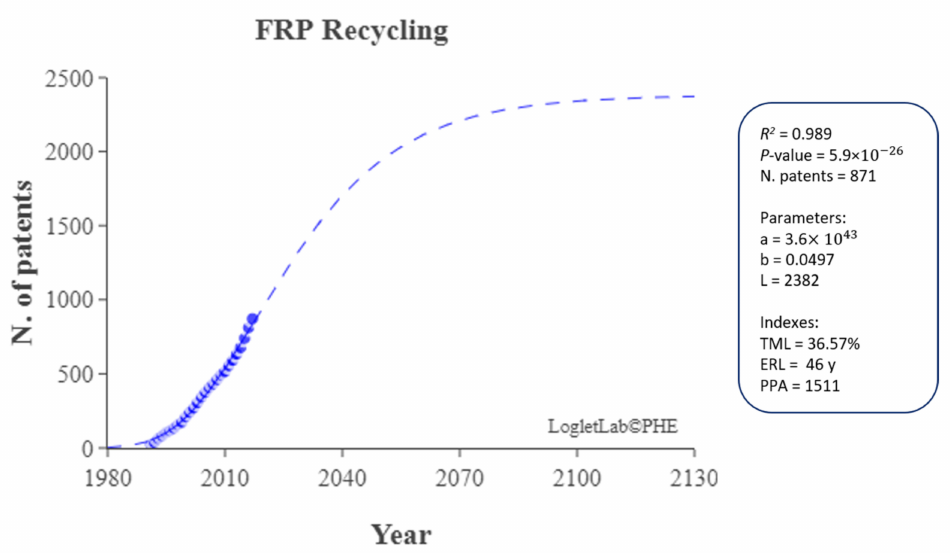
Figure 2. Gompertz growth curve and its parameters for FRP